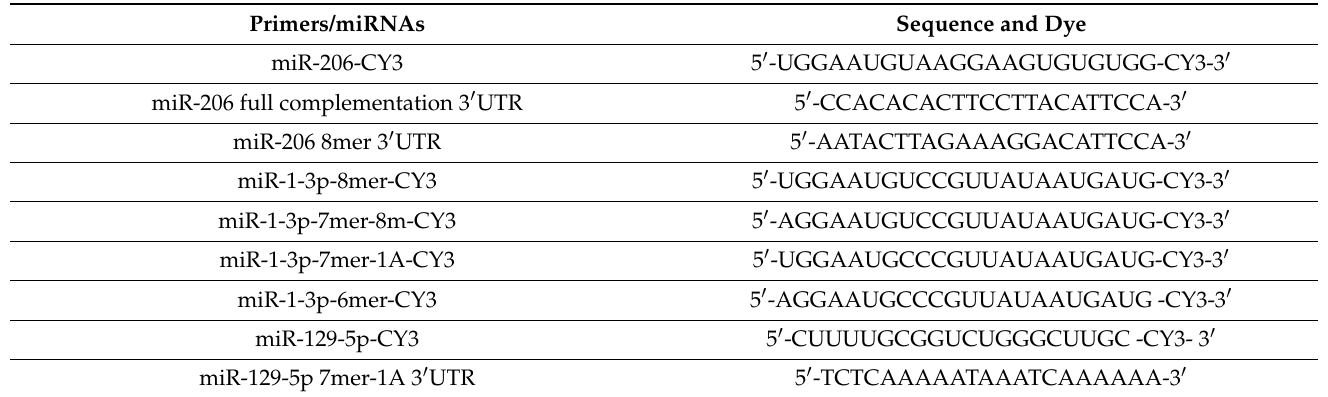
Table 1. Cont. Primers/miRNAs Sequence and